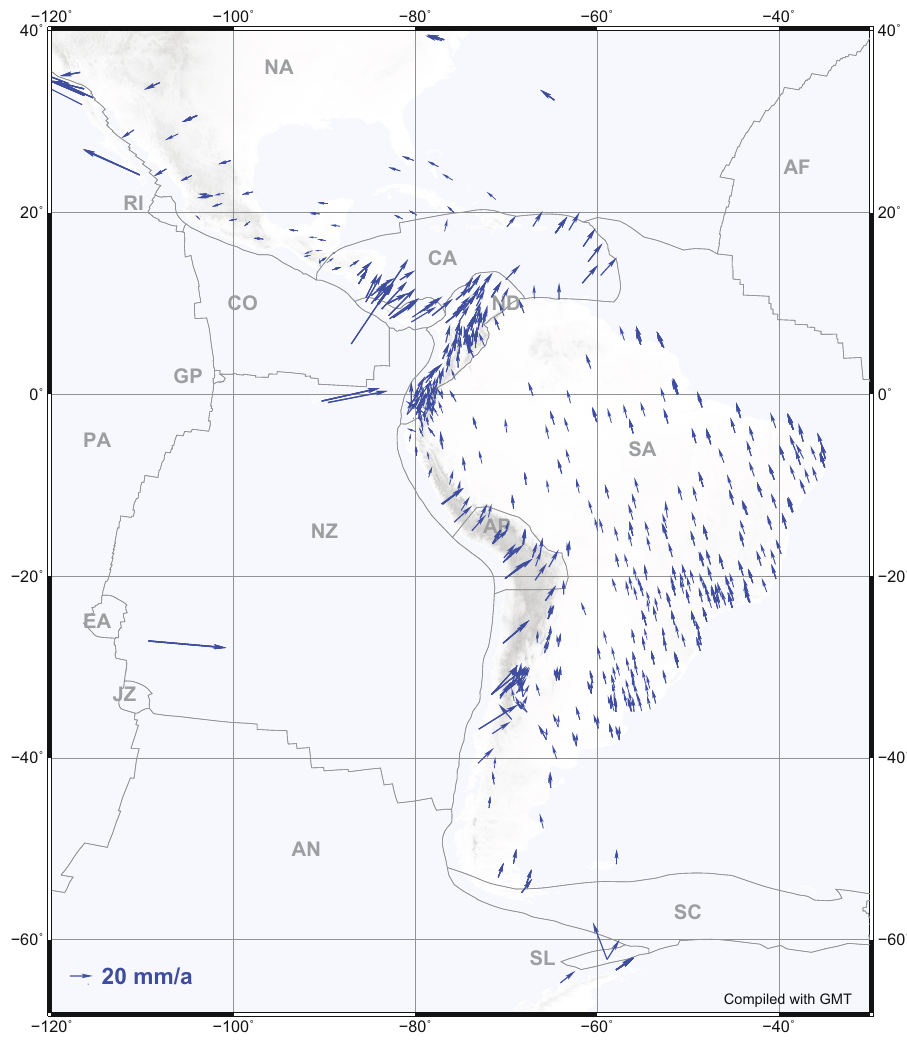
Figure 17: SIRGAS2022 horizontal